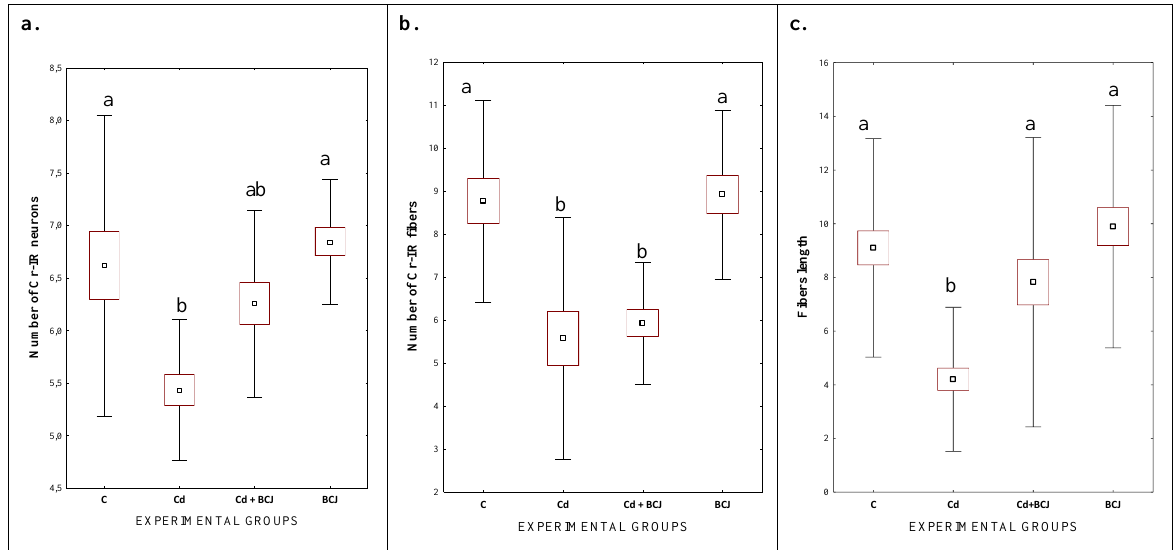
Figure 2. The figures present: the average numbers of Cr-IR neurons ( a ) and the average number of Cr-IR fibers ( b ) in the CA1 fields of rat hippocampus and the average length of nerve fibers ( c ). The data are expressed as means ± SEM (standard error of the mean; box) and standard deviation (whiskers); a,b —different letters indicate significant differences between the experimental groups at p ≤